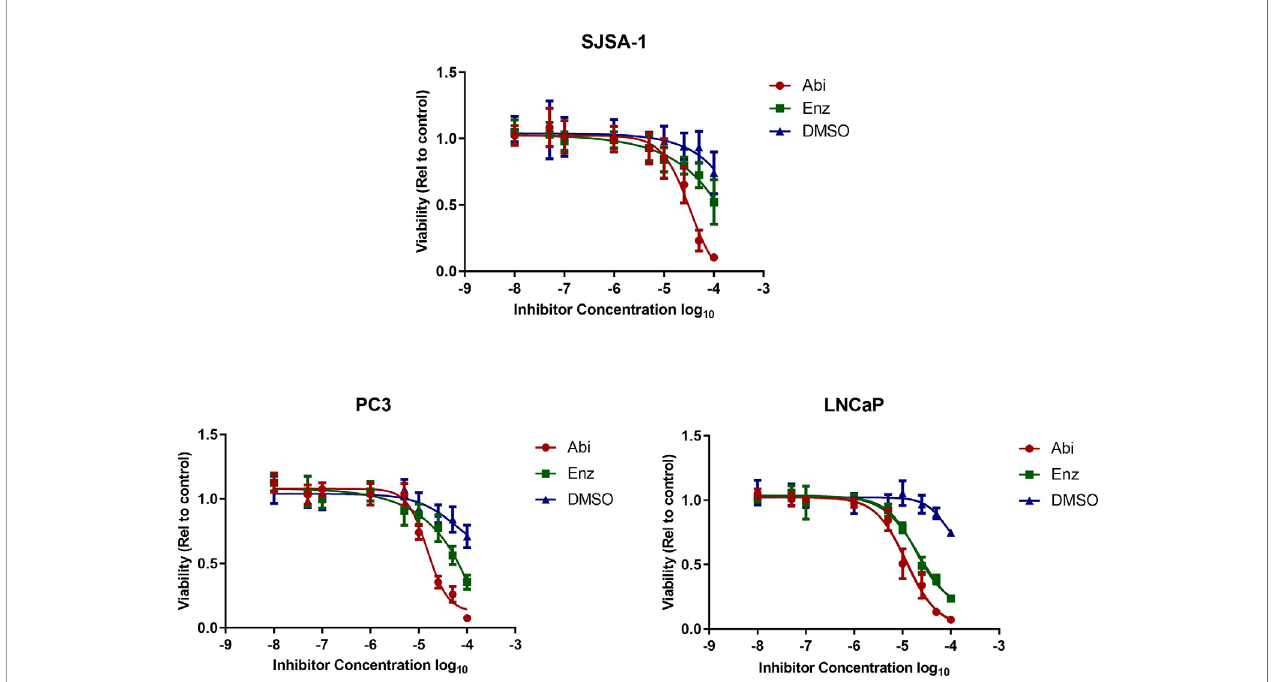
FIGURE 1 | Effect of Abiraterone and Enzalutamide treatment on cell viability of androgen-sensitive (LNCaP), androgen-insensitive (PC3) prostate cancer models and osteoblastic bone model (SJSA-1). LNCaP, PC3, and SJSA-1 cells were treated with a dose range of 10 nM to 100 m M of Abiraterone, Enzalutamide or DMSO. Cell viability was evaluated 72 hours post-treatment by MTT assay. Each value is the mean of three independent experiments performed in triplicate and error bars represent SEM.